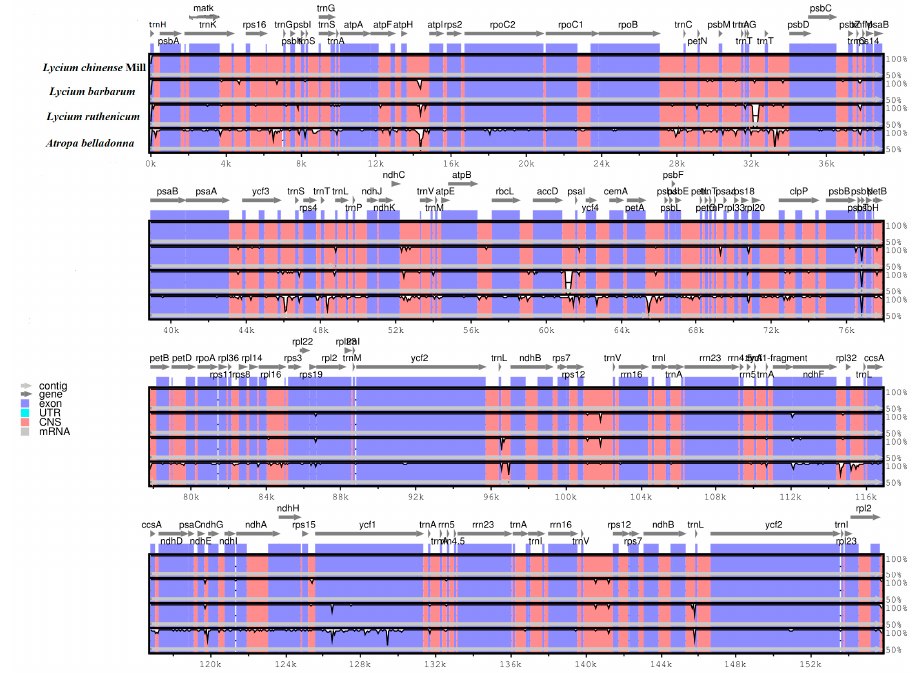
Figure 3. Sequence identity plot comparing five chloroplast genomes using mVISTA with L. chinense as the reference. Grey arrows and thick black lines above the alignment indicate genes with their orientation and the position of the inverted repeats (IRs), respectively. A cut-off of 70% identity was used for the plots, and the Y-scale represents the percentage identity ranging from 50% to 100%.